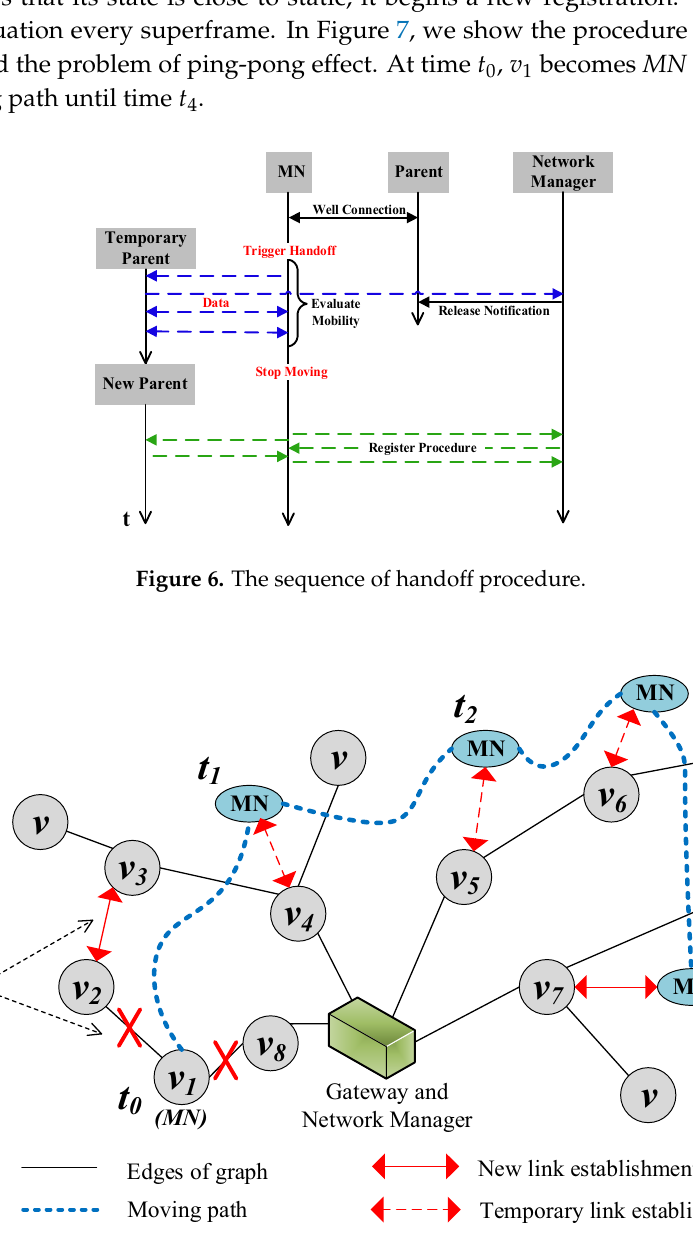
Figure 7. Movement of the mobile node from time t 0 to t 4